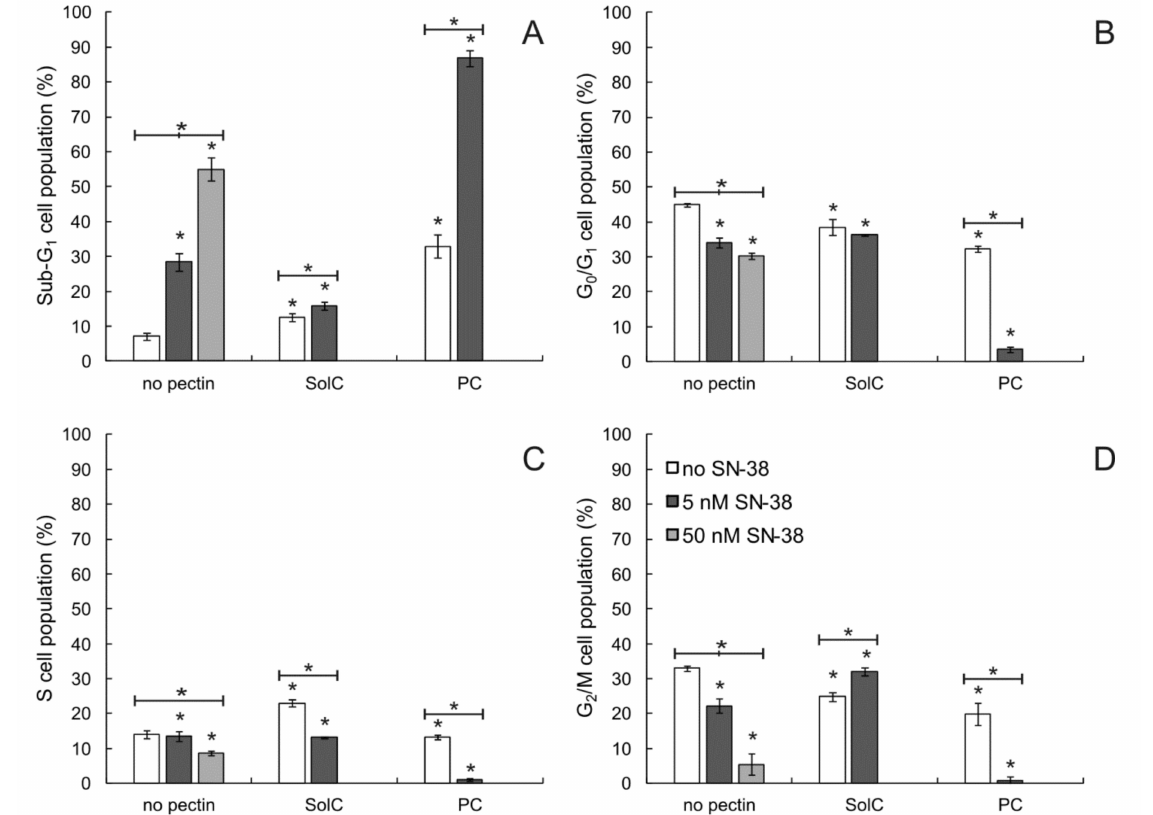
Figure 4. Cell cycle-dependent DNA content in HCT 116 cells treated with 0.2 mg/mL of pectins and /or SN-38 for 48 h. Sub-G1 population ( A )—dead cells, G0/G1 ( B )—mononuclear cells, S ( C )—DNA replication, G2/M ( D )—mitosis. Statistical significance was checked between the studied probes and controls (no pectin) as well as between probes containing only pectin and pectin combined with SN-38. * p < 0.05.